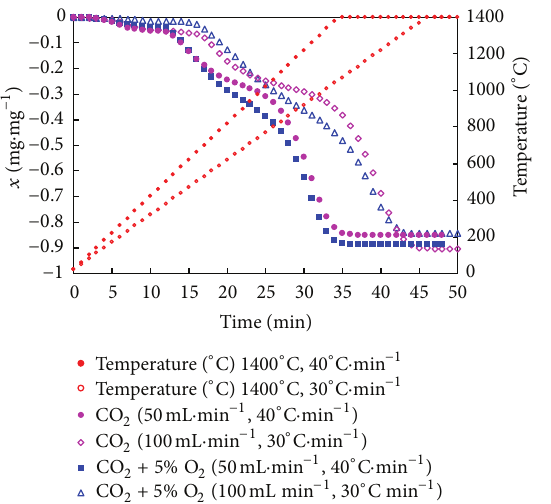
of oxidation combustion was enhanced by increasing temperature gradient from 40